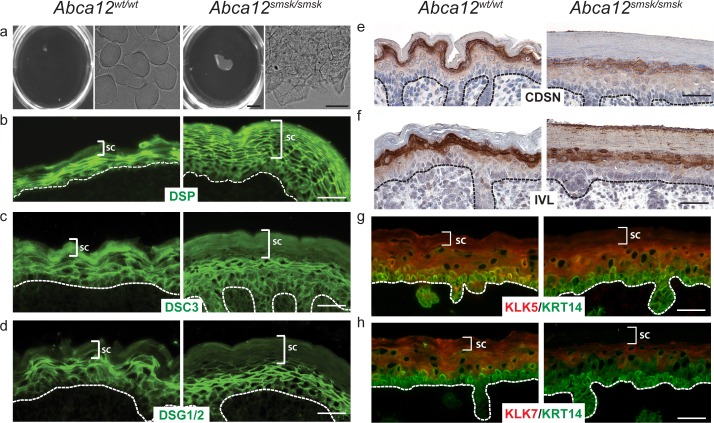
Enhanced adhesion of cornified envelopes in the Abca12smsk/smsk epidermis.E18.5 skin pieces from both WT and Abca12smsk/smsk embryos were boiled in cornified envelope (CE) extraction buffer. (a) WT skin pieces dissociated after boiling for 10 minutes, resulting in the dissolution of skin into individual CEs (Left panels). The mutant skins were never completely dissolved, even after extended hours of boiling. No individual CEs from the mutant skin were evident (Right panels). Bars = 5 mm and 20 μm, respectively. (b-f) Skin sections of both WT and Abca12smsk/smsk embryos showed (b) expression of DESMOPLAKIN (DSP), a component of both desmosomes and CDs, persisting throughout the thickened SC of the smsk epidermis; (c) a minor decrease in DESMOCOLLIN (DSC3) staining in the smsk SC; (d) no change in DESMOGLEIN (DSC) 1&2 staining in mutant skin versus WT; (e) reduced SC localization of CORNEODESMOSIN (CDSN) in mutant skin; (f) and INVOLUCRIN (IVL) staining throughout the SC of mutant mice but reduced levels in lower layers compared to WT skin. (g-h) Immunofluorescence detection of KLK5 and -7 revealed their presence in all layers of the WT epidermis with prominent expression observed at the junction between granular and cornified layers. In contrast, KLK staining was reduced in the smsk SC. Bars = 25 μm.